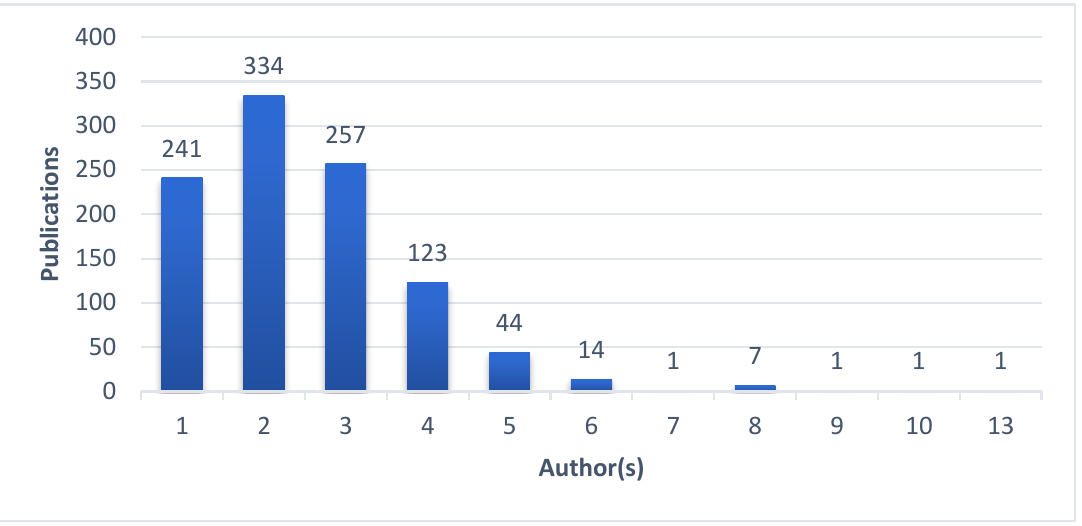
Figure 5. Authorship pattern of green marketing researchers.